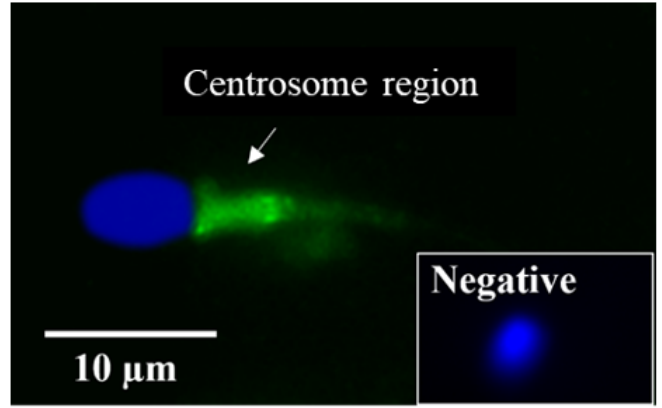
Figure 4. Localization of LGALS3BP using immunofluorescence (FITC; inset is negative control) and nuclear chromatin counterstaining (Hoechst) from a sperm cell isolated from the cauda of the epididymis.